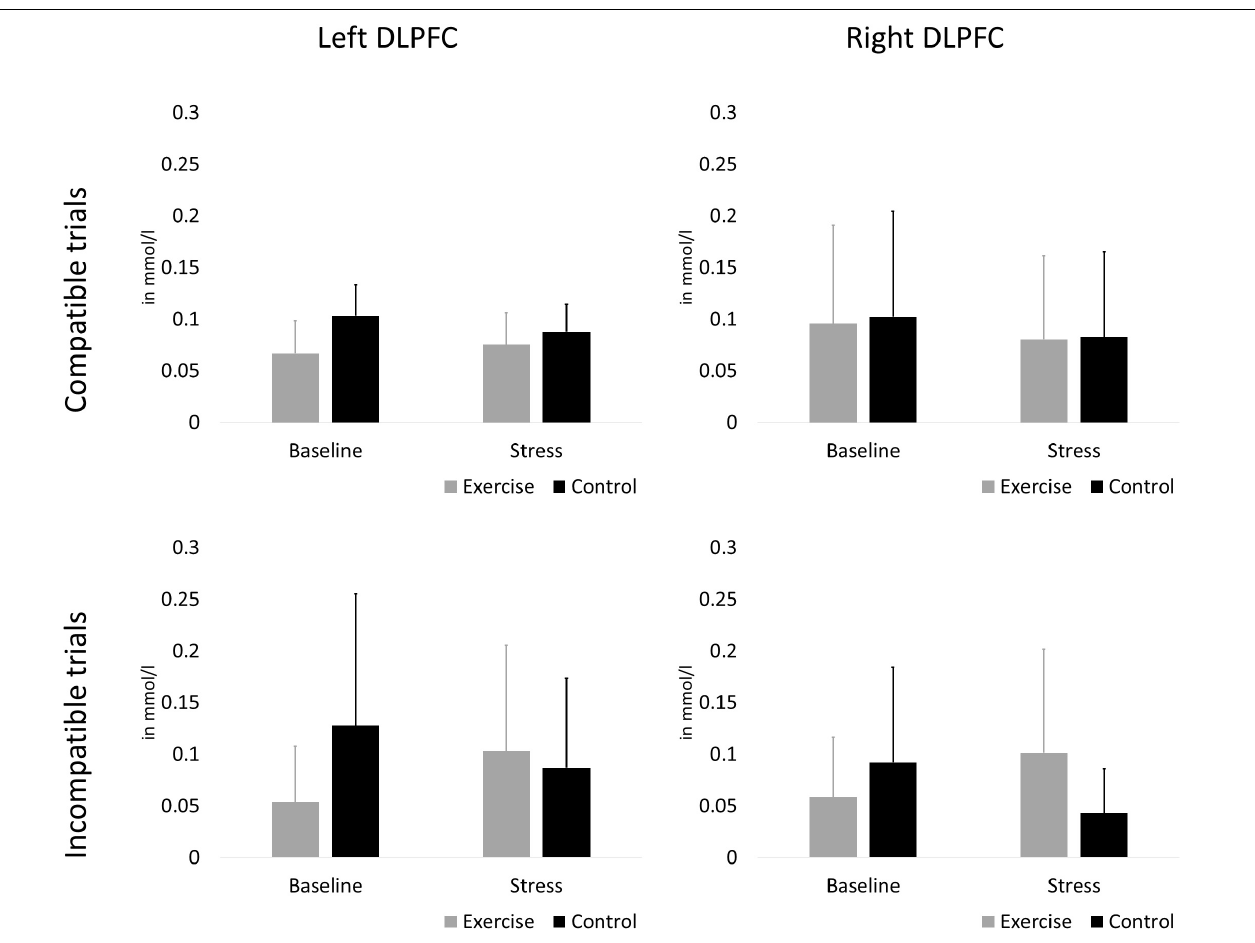
FIGURE 5 | Oxygenation changes in the left (A,C) and right (B,D) . DLPFC during compatible (A,B) and incompatible (C,D) test blocks. Error bars are standard errors of the mean (SEM).